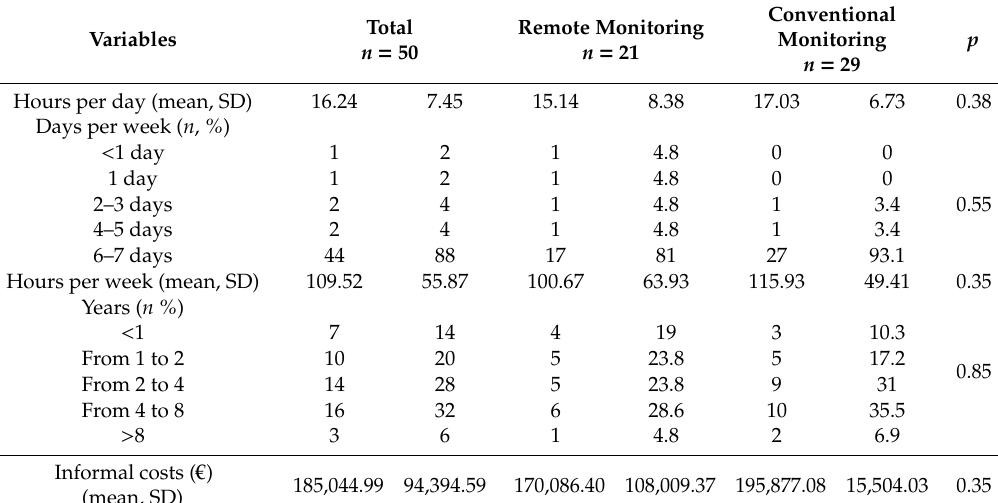
Table 2. Costs of informal care provided to patients with